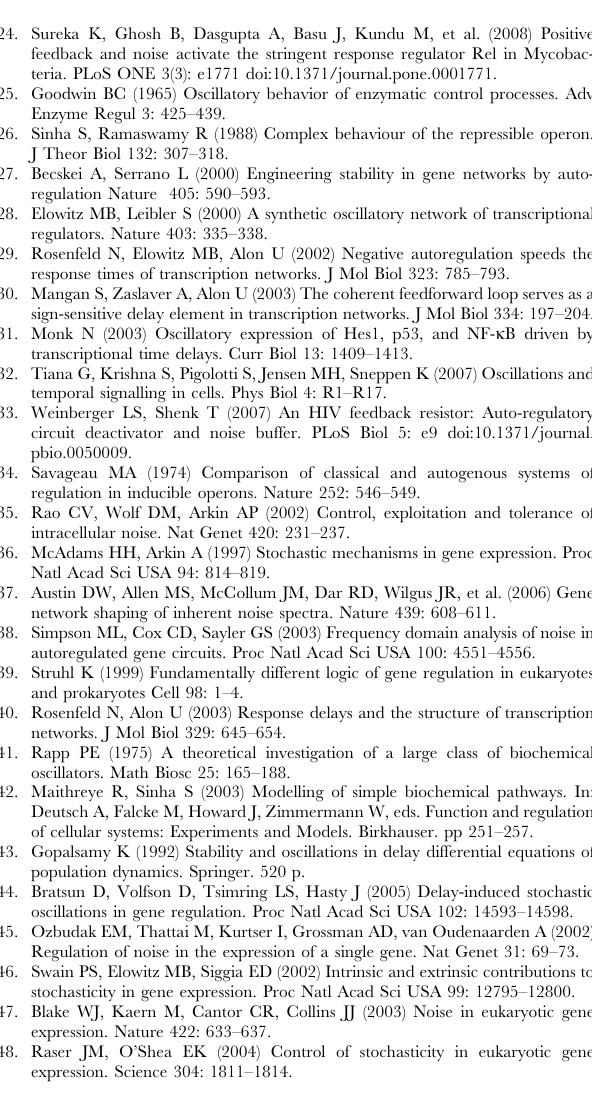
Figure S7 The effect of gating on the fluorescence distribution of the cells. TG (A) ungated and (B) gated; C2TG (C) ungated and (D) gated. X- axis= different time points represented in serial numbers, Y-axis = percentage of cells (white bars = R1; horizontal bars =R2 ; black bars = R3). Figure S8 Frequency distribution of the gated population at various time points after induction of the circuits (A) TG and (B) C2TG. The X- axis: fluorescence in arbitrary units; Y-axis Time in min; Z-axis: Frequency. Figure S9 Kinetics of TetR in the Basic (solid circles with dashed lines) and the Delay (squares with solid lines) circuits for (A) deterministic model and (B) stochastic model (average of 100 simulations).